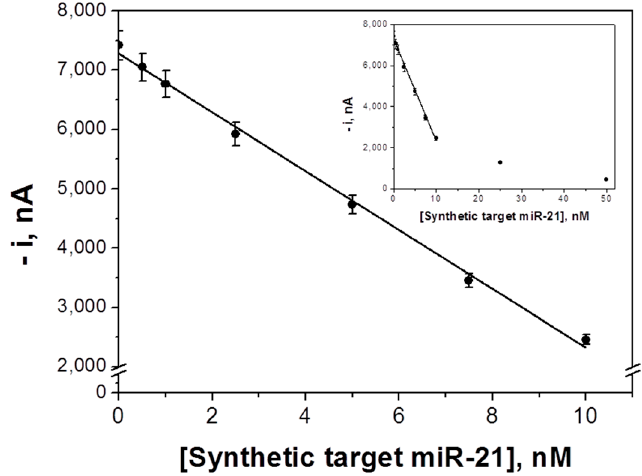
Figure 3. Calibration plot constructed for synthetic target miRNA-21 with the competitive DNA/RNA hybridization biosensor. Inset shows the saturation effect at higher concentrations of the target miRNA. Error bars estimated as three times the standard deviation of three replicates.